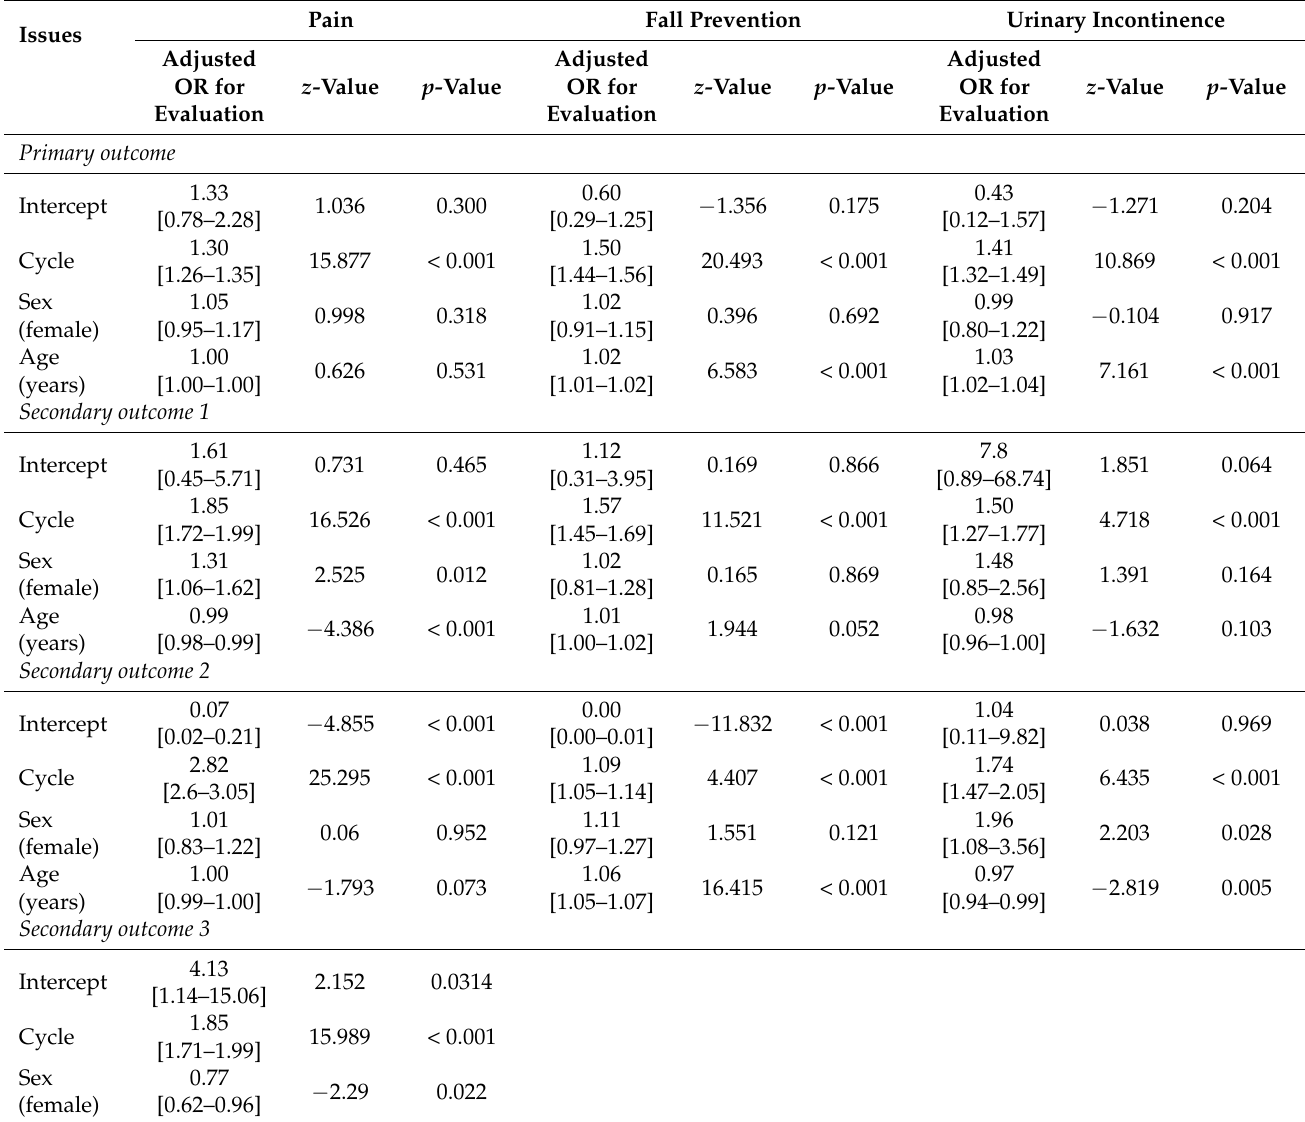
Table 3. Logistic regression models of compliance as a function of the cycle and patients’ sex and